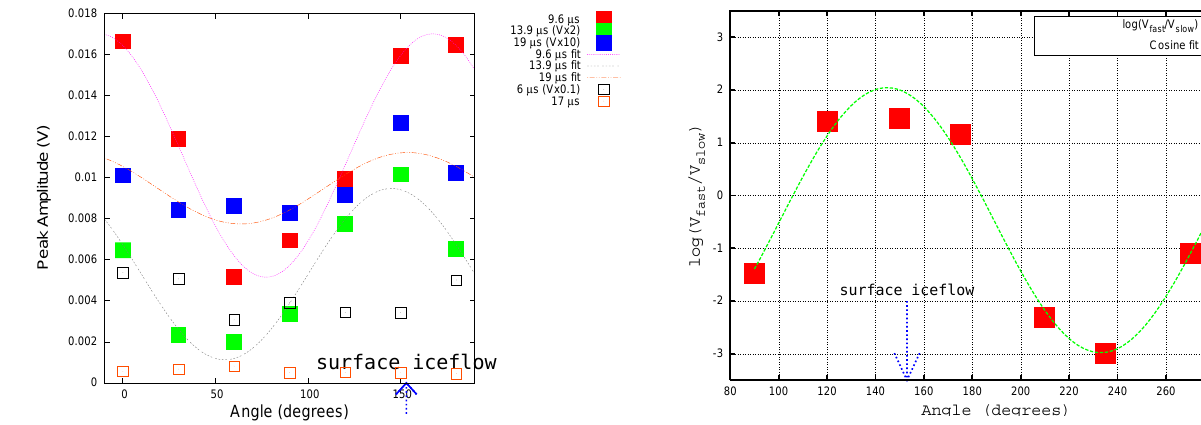
Fig. 12. Data of previous table presented in graphical form, with sinusoidal fits overlaid. Blue arrow indicates azimuth corresponding to local horizontal ice flow direction.